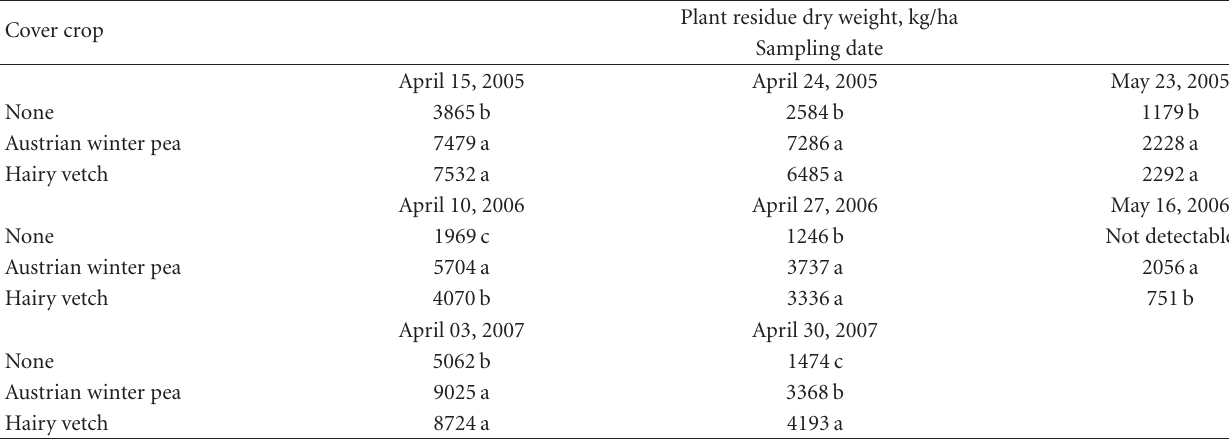
Table 1: E ff ect of cover crop on plant residues remaining on soil surface at various times in 2005, 2006 and 2007. a